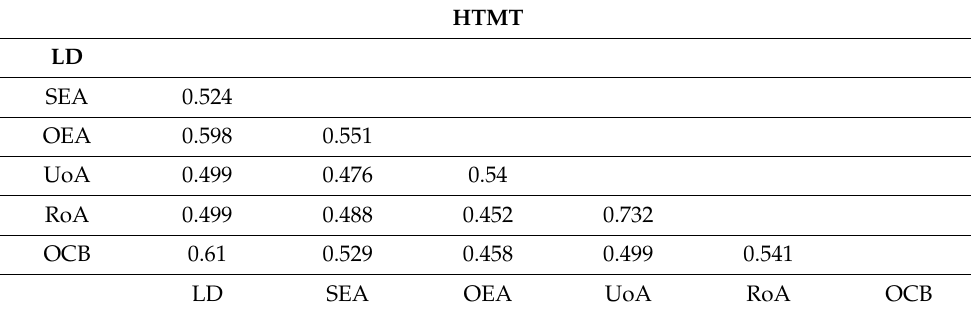
Table 4. Heteotriat–Monotrait (HTMT) Ratio of Correlation.